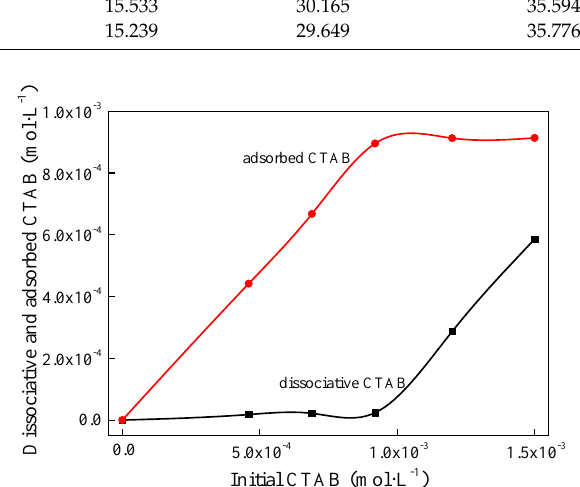
Figure 5. The dissociative and adsorbed CTAB after the hydrothermal reaction.